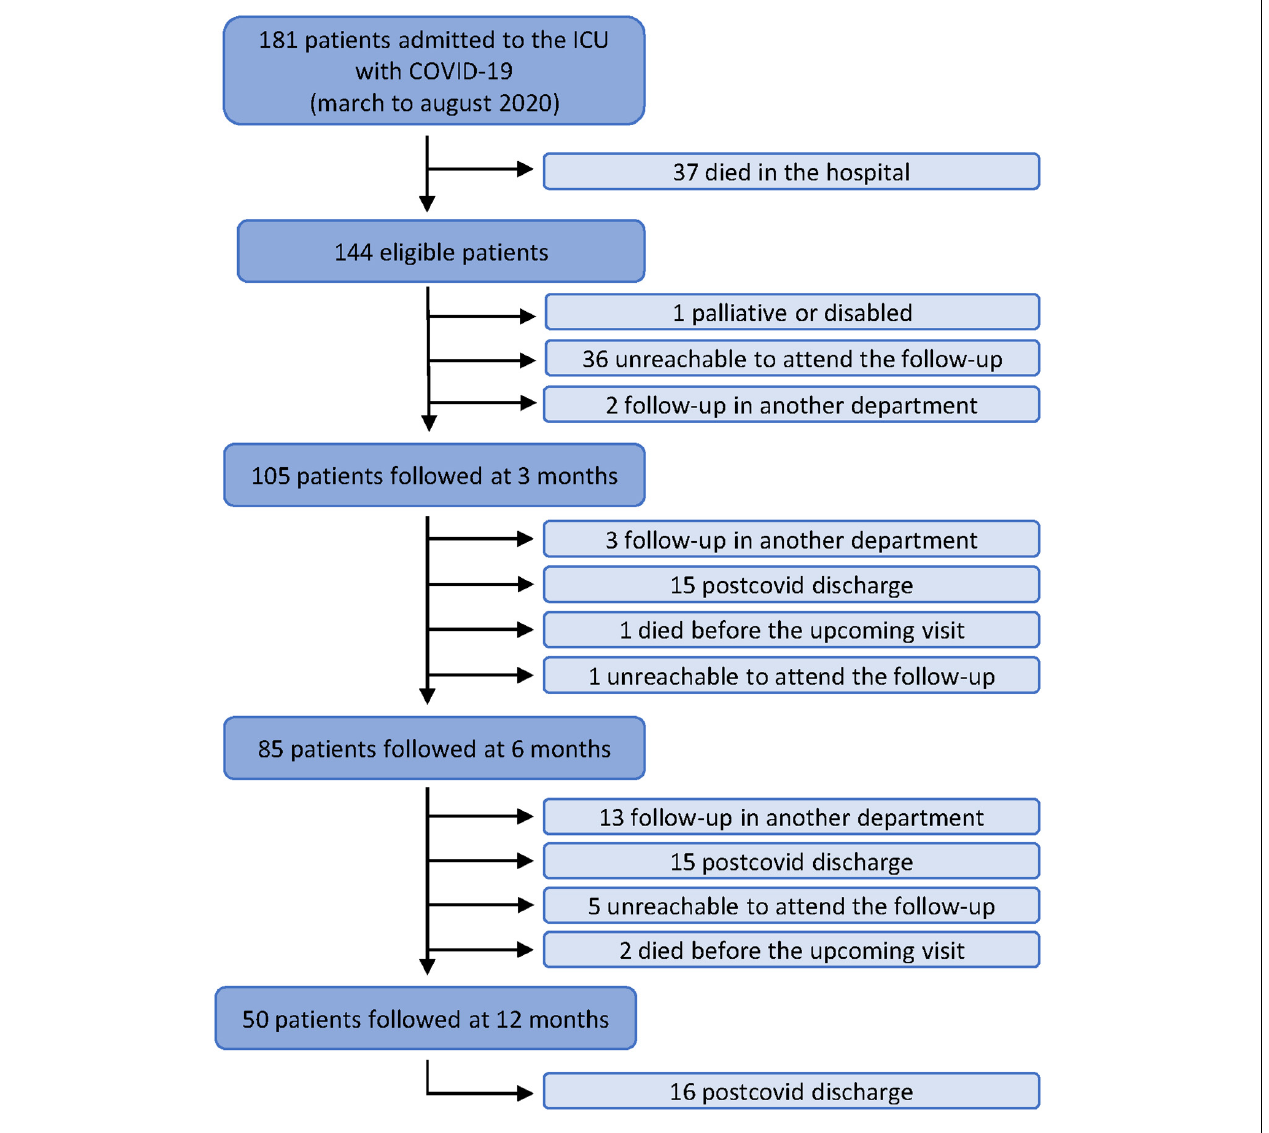
FIGURE 1 | Flowchart of the